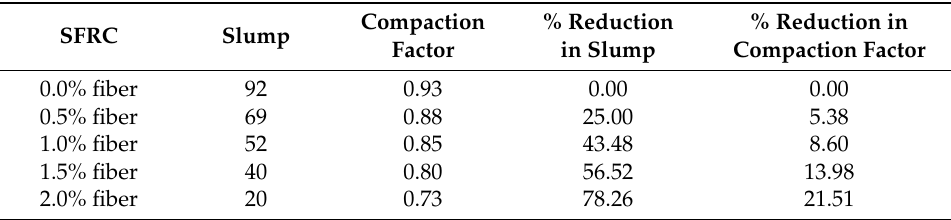
Table 6. Slump and compaction factor value of